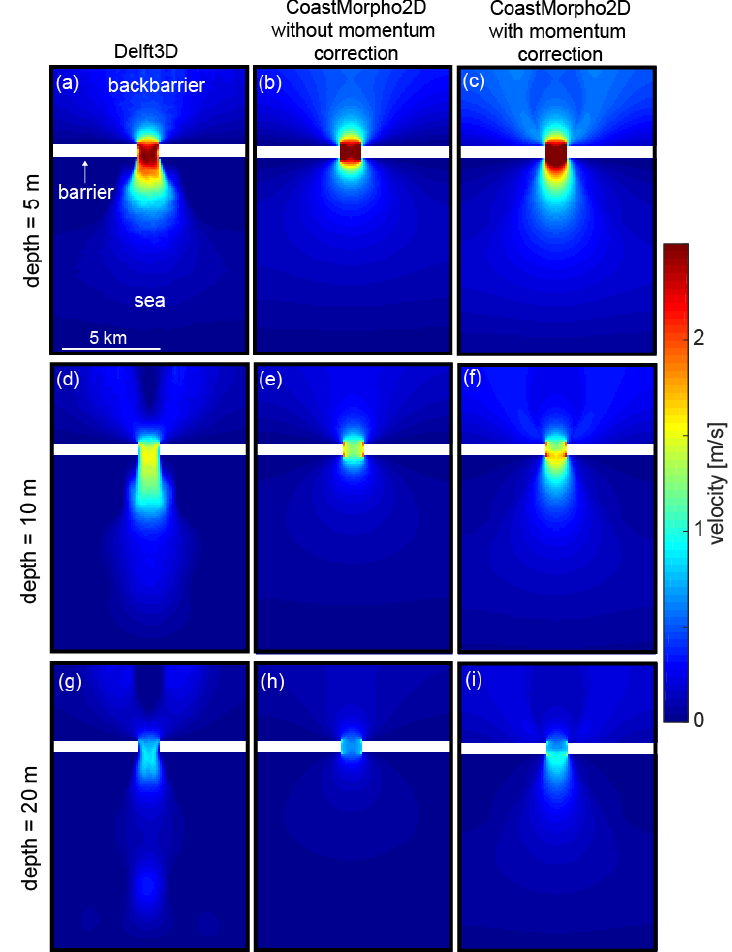
Figure 2. Hydrodynamic comparison between Delft3D and CM2D. Both models simulate the flow